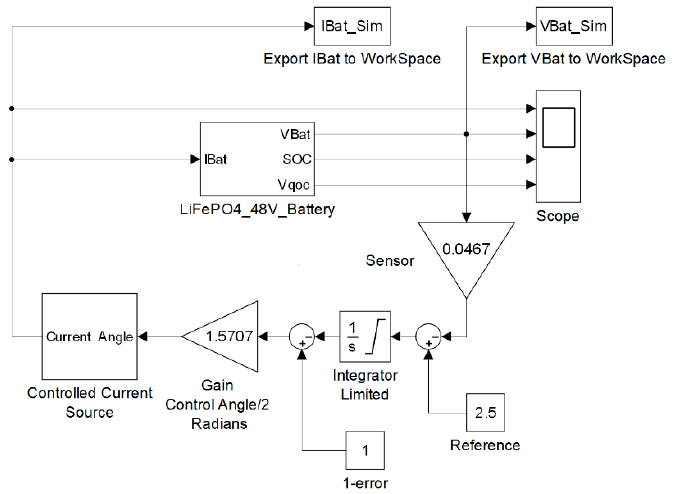
Figure 11. Control loop for limiting the maximum battery voltage, V Bat(Max) .